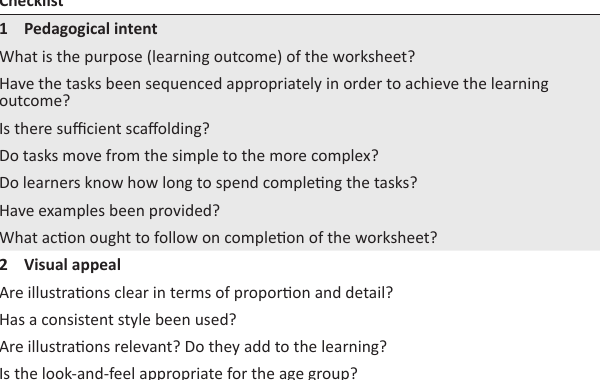
TABLE 1-A1: Designing and implementing